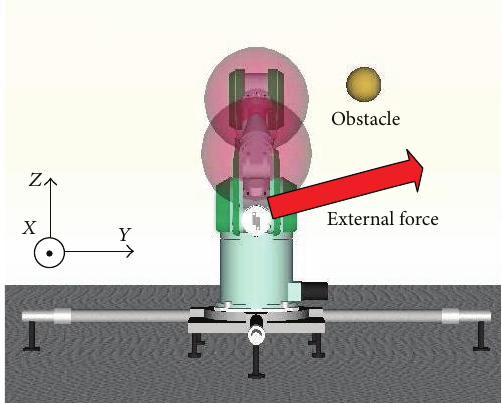
Figure 10: Obstacle avoidance in simulation.